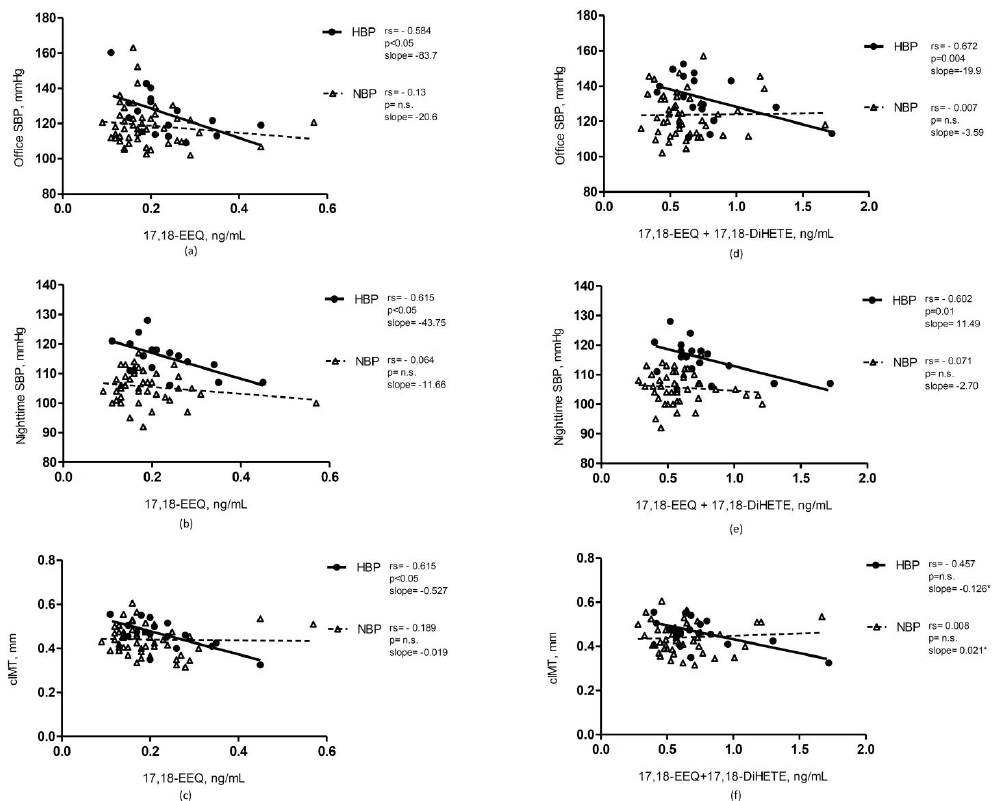
Figure 3. Correlations of EEQ with BP and cIMT in the high blood pressure (HBP) and normal blood pressure (NBP) obese children subgroups. The first column represents the correlation of 17,18-EEQ with: ( a ) office SBP; ( b ) night-time SBP; ( c ) cIMT. The second column represents the correlation of the estimated CYP450 epoxygenase activity, as calculated as the sum of epoxymetabolites plus the corresponding diols, with: ( d ) office SBP; ( e ) night-time SBP; ( f ) cIMT. * there is a significantly difference between the slopes of the two subgroups, p < 0.05. The correlations in all panels are stronger in HBP than in NBP children. The two subgroups of obese children with high and normal blood pressure are differently graphically depicted. cIMT: carotid intima-media thickness; EEQ: epoxyeicosatetraenoic acid; DiHETE: dihydroxyeicosatetraenoic acid; HBP: high blood pressure subgroup; NBP: normal blood pressure subgroup; SBP: systolic blood pressure, p : p -value; r S : Spearman correlation coefficient.